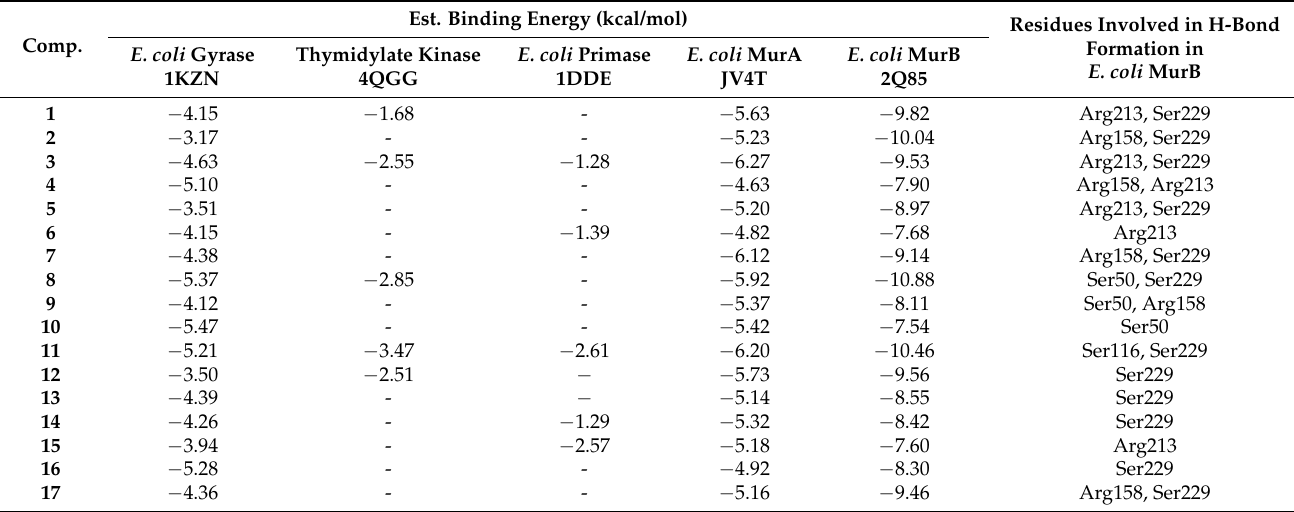
Table 4. Molecular docking free binding energies (kcal/mol) to antibacterial targets.